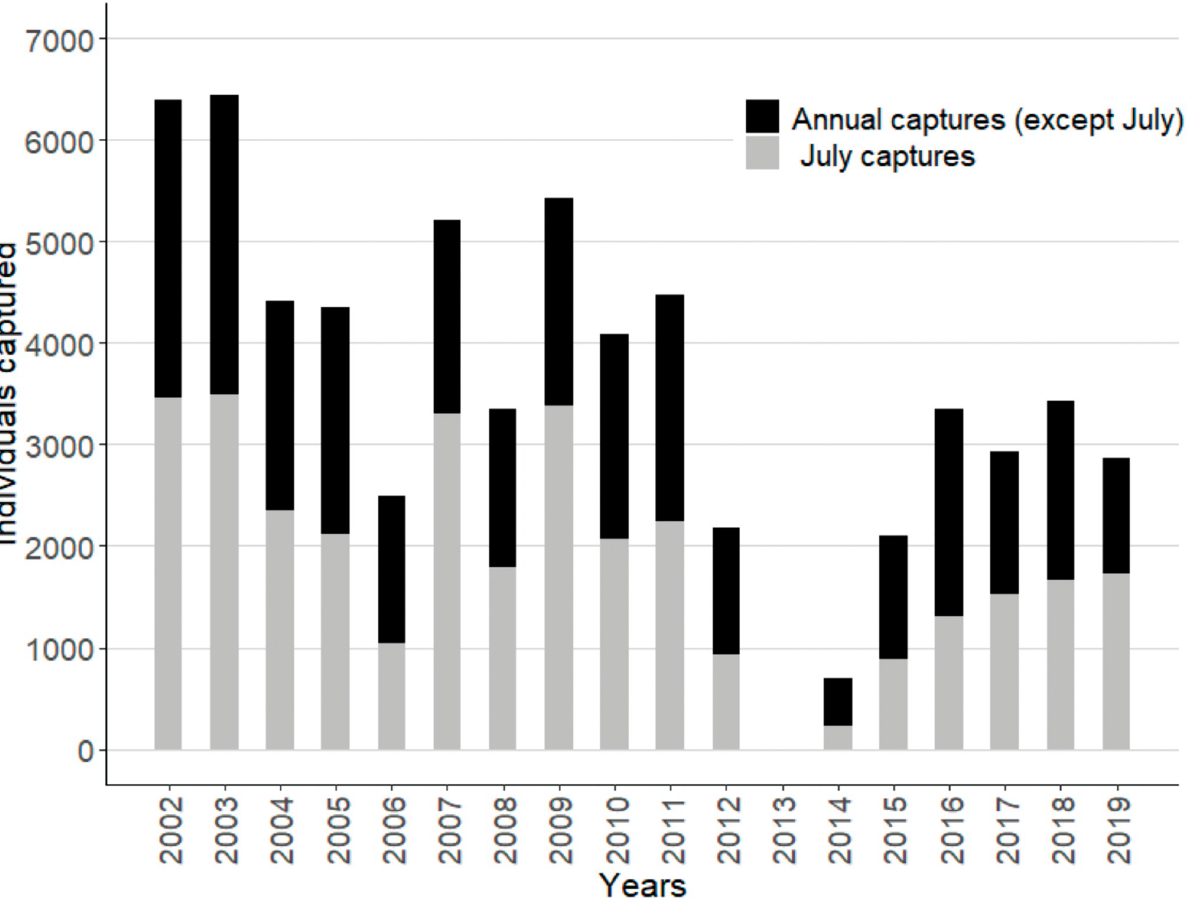
Fig 3. Yellow anacondas ( Eunectes notaeus ) harvested by the Programa Curiyú between 2002–2019 in northeastern Argentina. Total annual captures and captures in the most productive month (in grey) are shown.